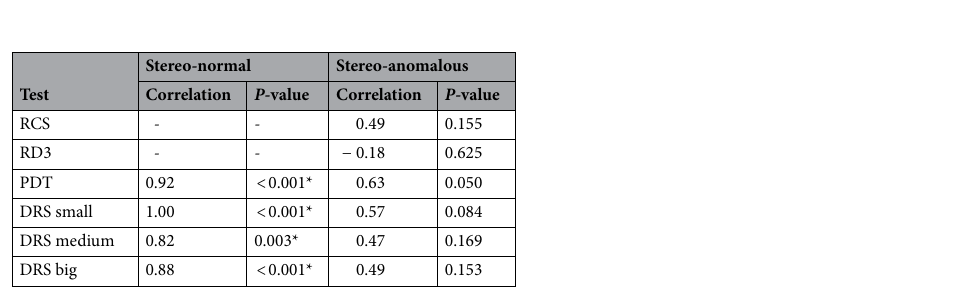
Table 2. Correlation coefficients and p-values using Pearson’s test between PPR and initial stereoacuity values for stereo-normal and stereo-anomalous